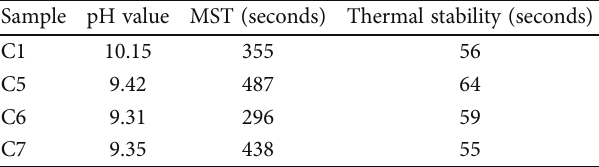
Table 5: Physical and mechanical properties of the vulcanized fi lm. Sample